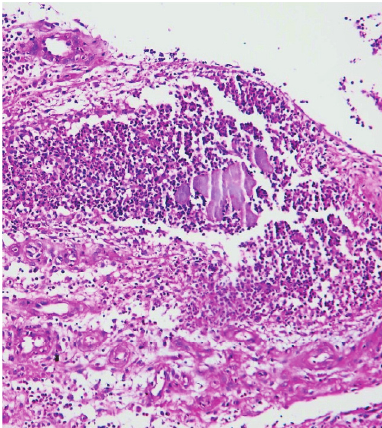
Figure 2: Histopathology view: ulcerated epidermis with under- lying neutrophilic microabscess surrounded by granulation tissues consisting of plasma cell, macrophage, and fibroblast infiltration (H&E ∗ 10).